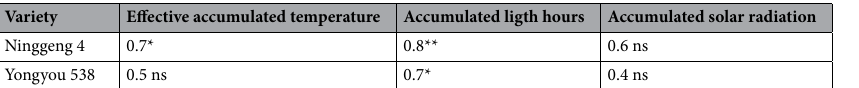
Table 3. Relation between yield and temperature and light resources in vegetative stage of different treatments from 2019 to 2020.